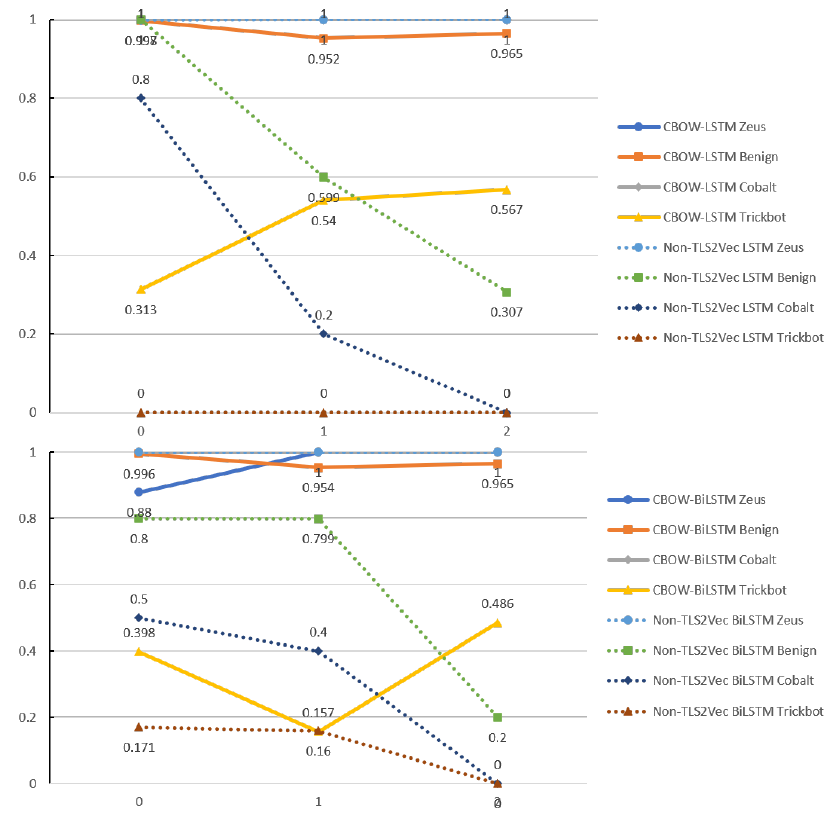
Figure 4. The multiclass target with LSTM ( upper ) and BiLSTM ( lower ). The x-axis is the payload from zero to two or more, while the y-axis is the F1